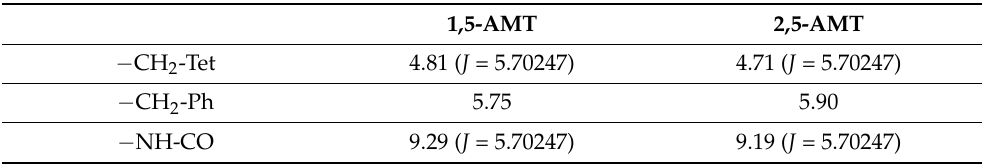
Table 1. 1 H Chemical shift assignments (in ppm) and coupling constants (in Hz) in 1,5- and 2,5-AMTs derivatives (DMSO- d 6